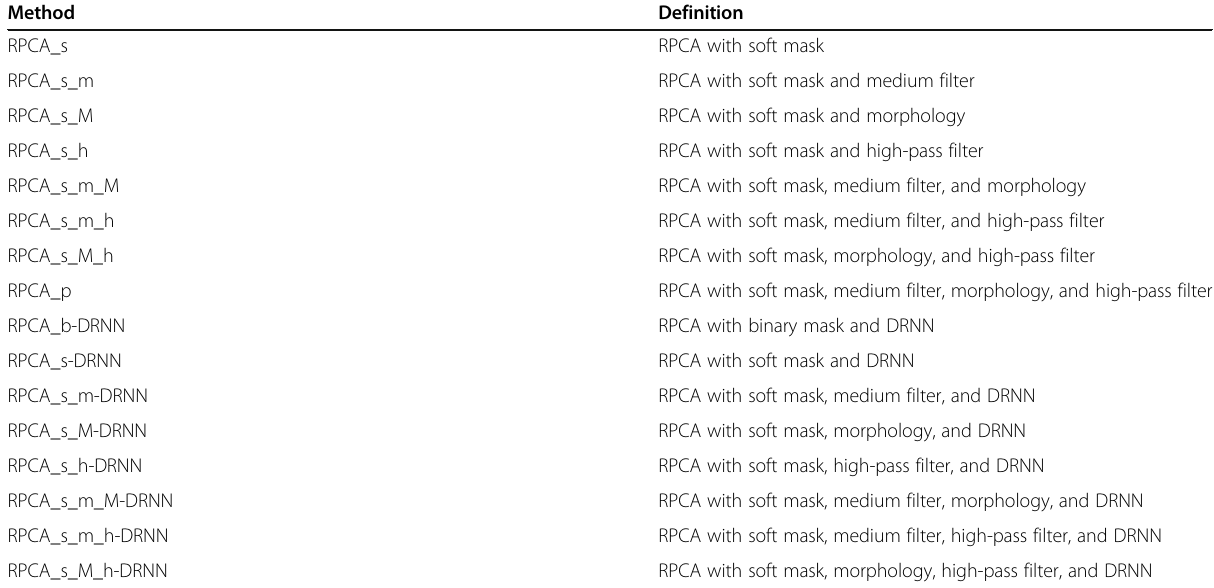
Table 1 Combinations of different parts of RPCA-DRNN